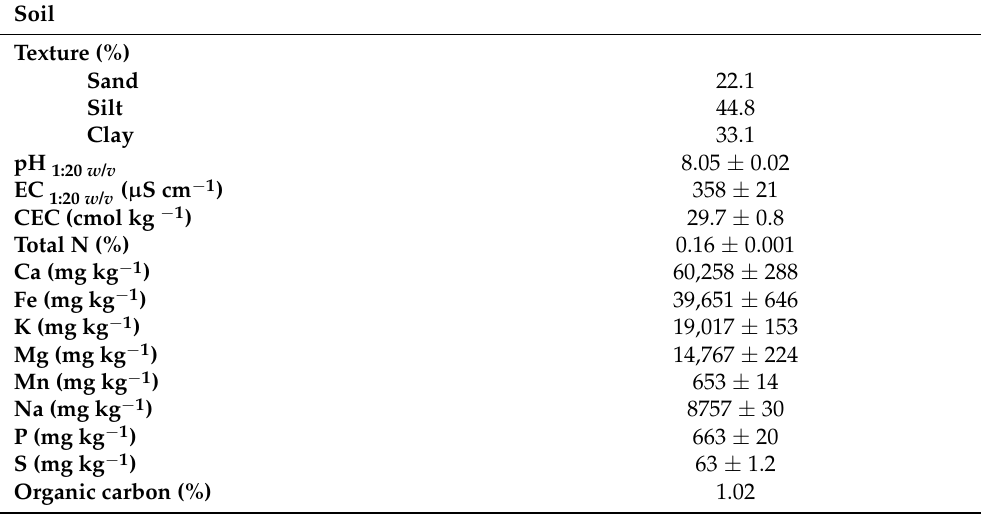
Table 2. Chemical characteristics of the soil index used before transplanting